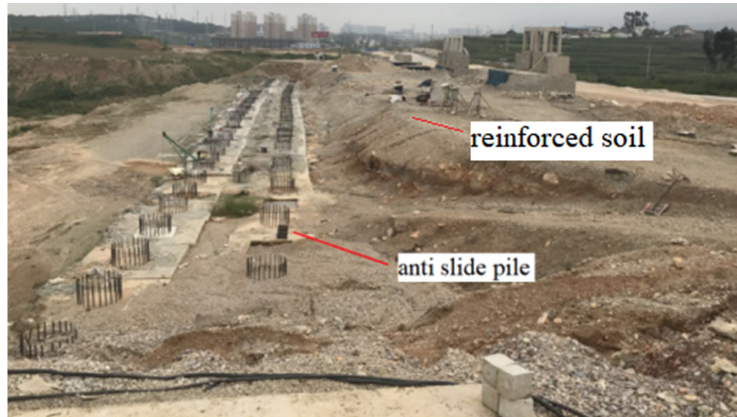
Figure 16. Site construction of reinforcement scheme.